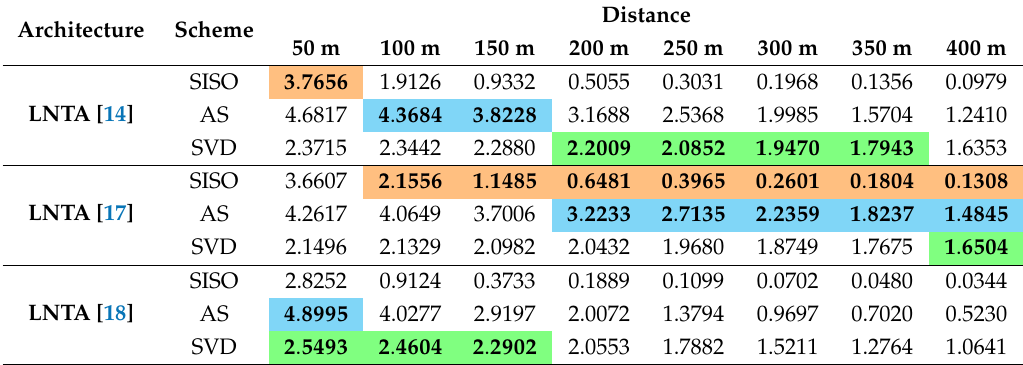
Table 4. Energy efficiency, in bit/J/Hz, as a function of the distance for the different LNTA architectures and transmission schemes, with N t = N r =